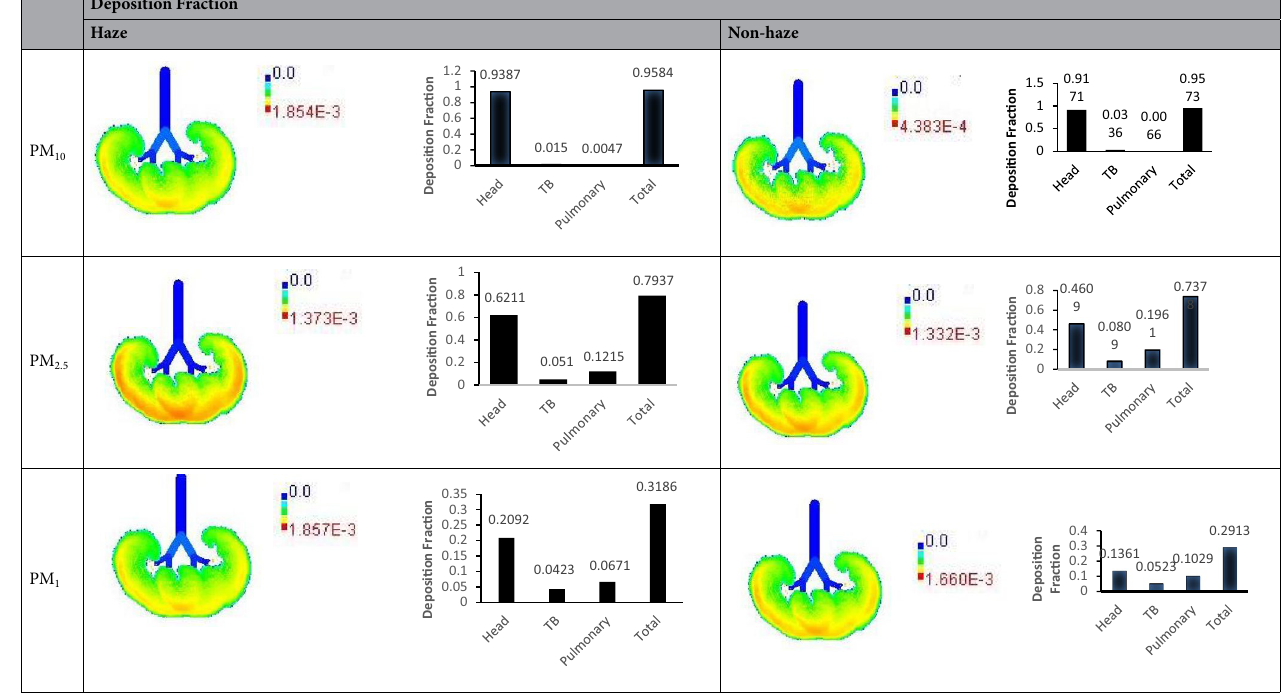
Table 2. Illustrations of particle deposition in human lungs; and deposition fraction values in the head, tracheobronchial (TB) and pulmonary regions during haze and non-haze